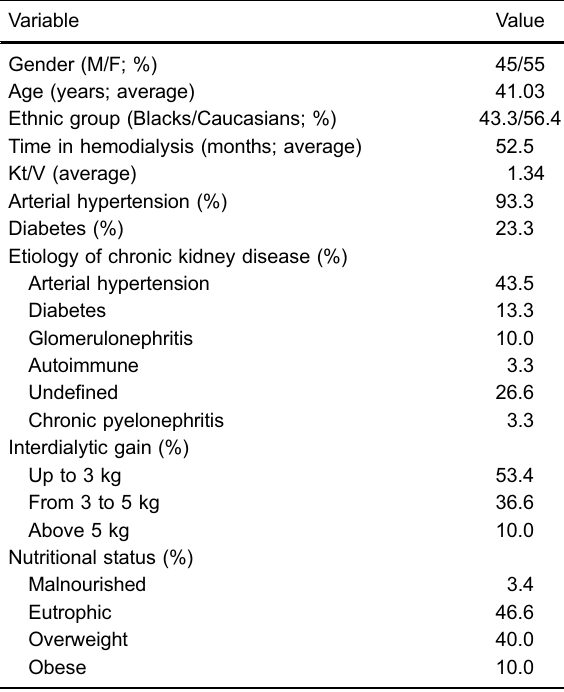
Table 1. Demographic, anthropometric, and nutritional character- istics of the study